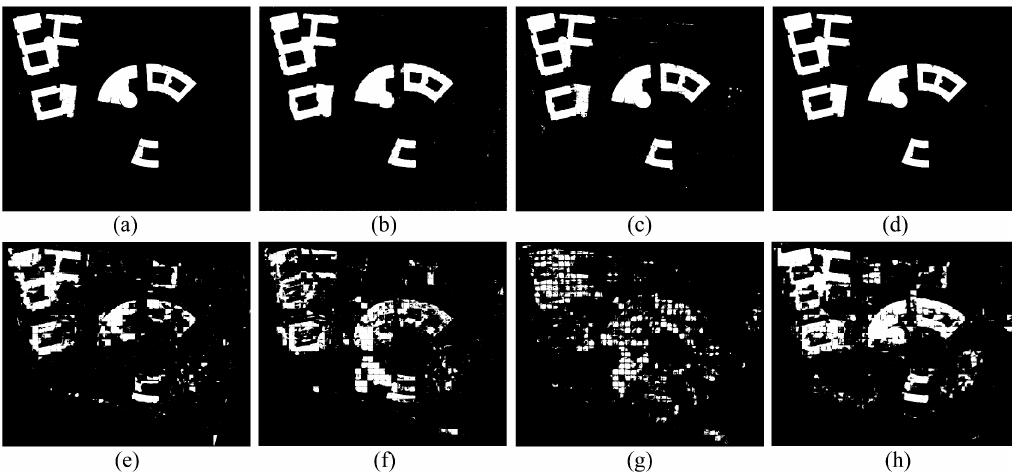
Figure 15. Binary change maps (Experiment 4) obtained by the ( a ) U-Net_Multi-feature, ( b ) SegNet_Multi-feature, ( c ) DeepLabv3+_Multi-feature, ( d ) squeeze-and-excitation W-Net_Multi-feature, ( e ) U-Net_only-image, ( f ) SegNet_only-image, ( g ) DeepLabv3+_only-image, and ( h ) squeeze-and-excitation W-Net_only-image.